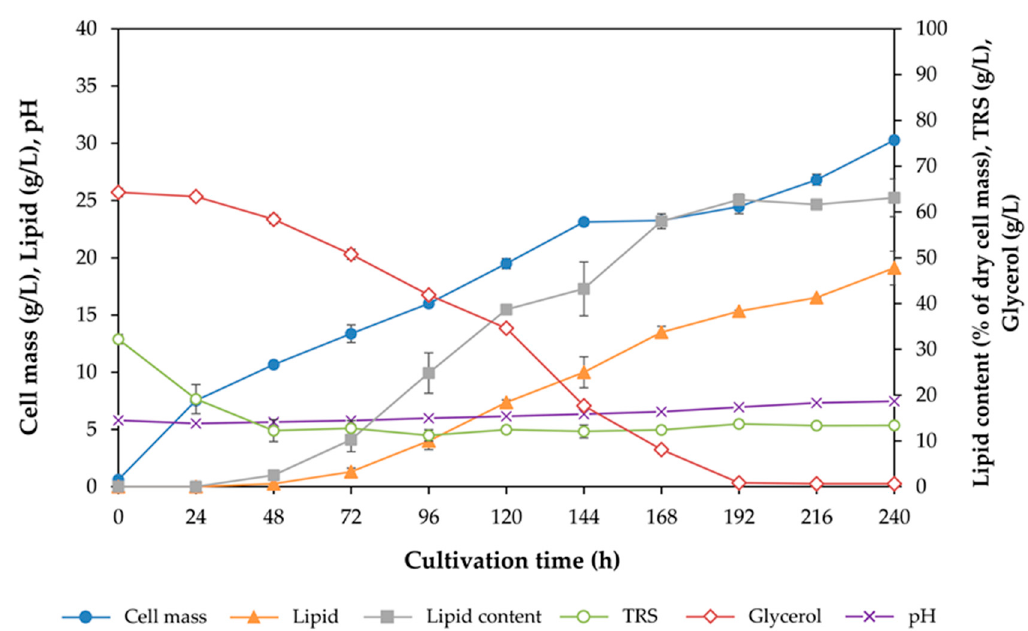
Figure 3. Time course of cell mass, lipid, lipid content, total reducing sugars (TRS), glycerol, and pH during batch cultivation of Rhodosporidiobolus fluvialis DMKU-SP314 in a 3 L stirred-tank fermenter at 28 °C, 200 rpm agitation speed, and 2 vvm aeration rate.